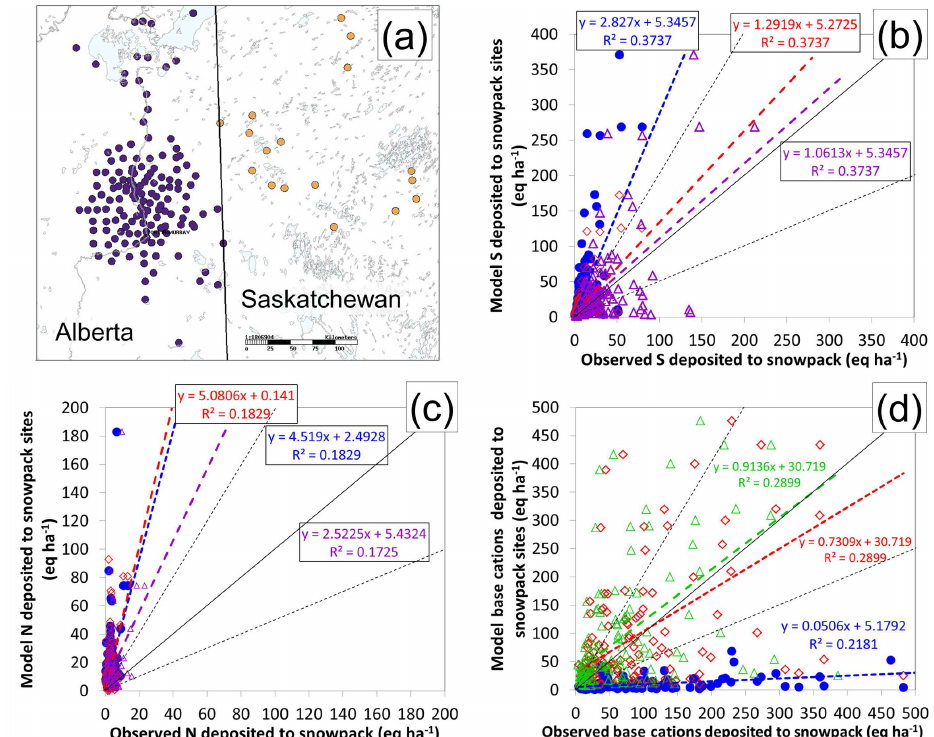
Figure 10. (a) Snowpack sample collection sites (purple: Environment and Climate Change Canada sampling sites; orange: Saskatchewan Environment sampling sites). (b, c, d) : Relationships between modelled and snowpack-derived S dep , N dep and BC dep , fluxes, respectively. Blue lines: uncorrected model estimates compared to uncorrected snowpack observations. Red lines: Model estimates corrected using down- wind precipitation observations (b, c, d) and aircraft-obervation-based fugitive dust emissions estimates (d) . Purple lines: original model values compared to snowpack-derived loads corrected by the expected ratios of throughfall to open surface collection for S dep (b) and N dep (c) . Green line (d) : model BC dep estimates scaled using precipitation and aircraft observations paired with observations corrected by the expected ratio of throughfall to open surface collection for PM 2 . 5 . Units are eqha − 1 for the snowpack sampling periods; model values are the sum of hourly values during snowpack sampling